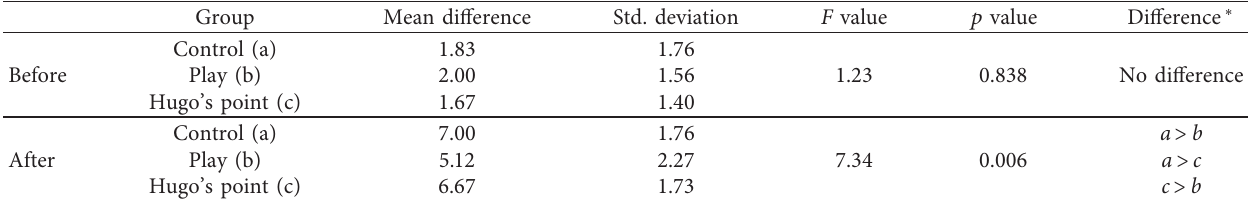
Table 2: One-way analysis of variance (ANOVA) to compare the perceived pain intensity in study groups before and after IV-line